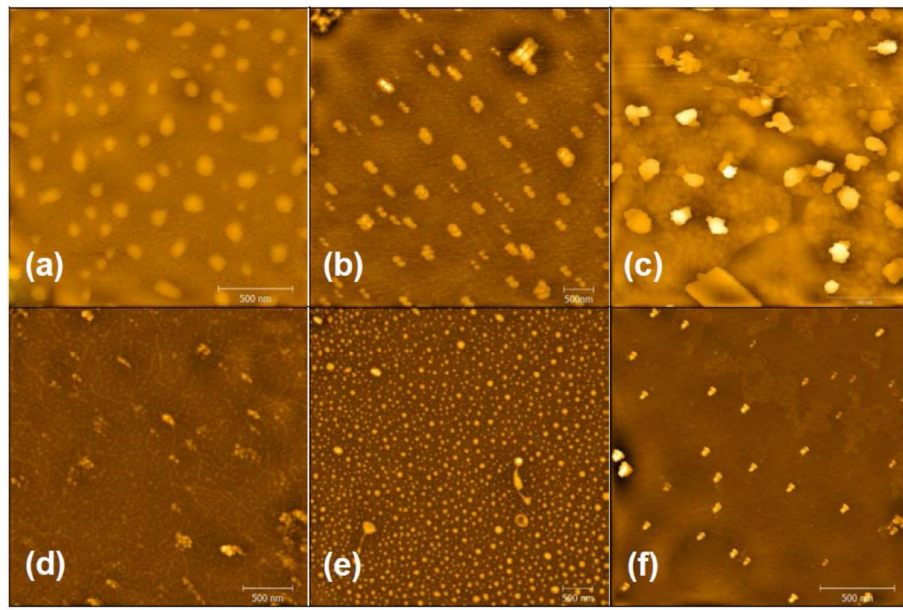
Figure 3. Atomic force microscopy (AFM) images of post-esterification microfluidized (PeM) cellulose nanoparticles (CNPs). ( a ) CNP-S07T85t1; ( b ) CNP-S05T80t2; ( c ) CNP-S01T80t2; ( d ) CNP-N10T80t1; ( e ) CNP-N10T60t2; ( f )